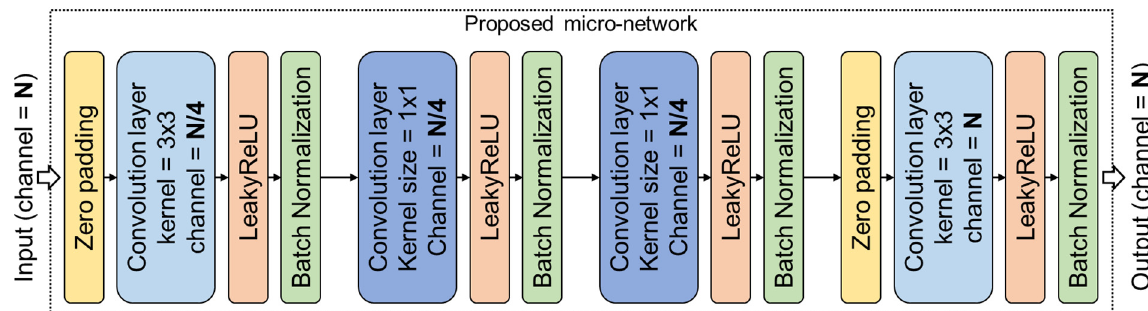
Figure 5. The layer configuration of the proposed micro-network. The yellow, light blue, orange, green, and dark blue squares refer to the zero-padding layer, convolution layer with 3 × 3 kernel size, LeakyReLU activation layer, and batch normalization layer, respectively.